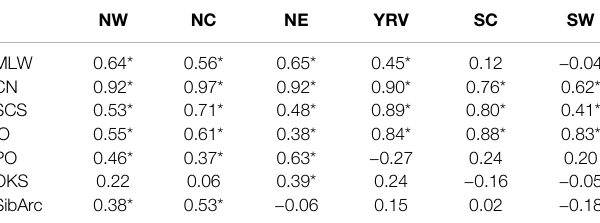
TABLE 2 | Correlation coef fi cients between total precipitation and related source precipitation in different subregions. Asterisks denote correlation coef fi cients exceeding the 95% con fi dence